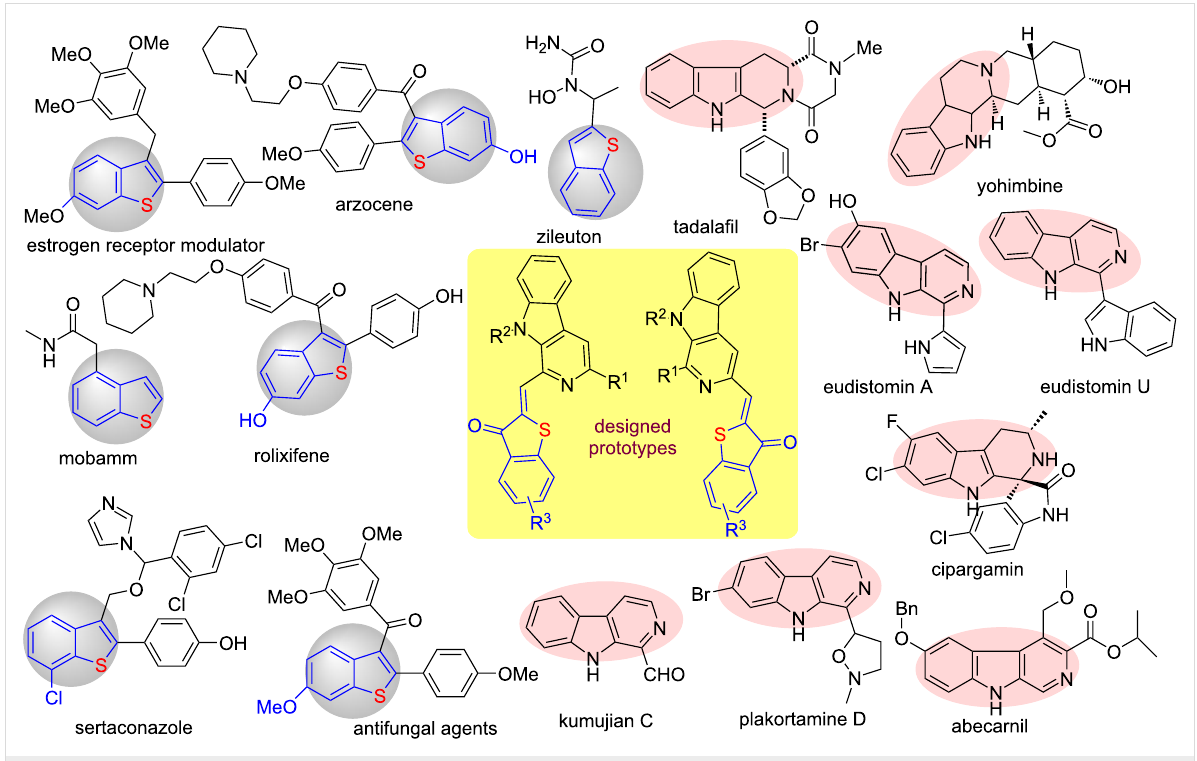
Figure 1: Representative examples of some commercial drugs and biologically active alkaloids.